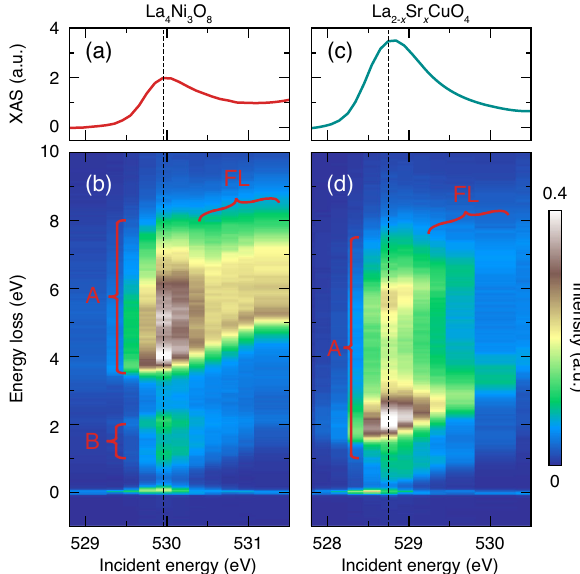
FIG. 2. Comparison of RIXS spectra in La 4 Ni 3 O 8 and La 2 − Sr CuO 4 . XAS plots and RIXS intensity maps across the x x prepeak energies for (a,b) La 4 Ni 3 O 8 and (c,d) La 2 − The data were collected with θ ¼ 15 ° and σ polarization. Differ- ent contributions can be identified, including the fluorescence (FL) and resonant signals (labeled as features A and B). The vertical dashed lines indicate the prepeak resonant energy. XAS data are shown in arbitrary units (a.u.) normalized to 0 and 1 at energies 1 eV below and 1 eV above the prepeak [50,52].